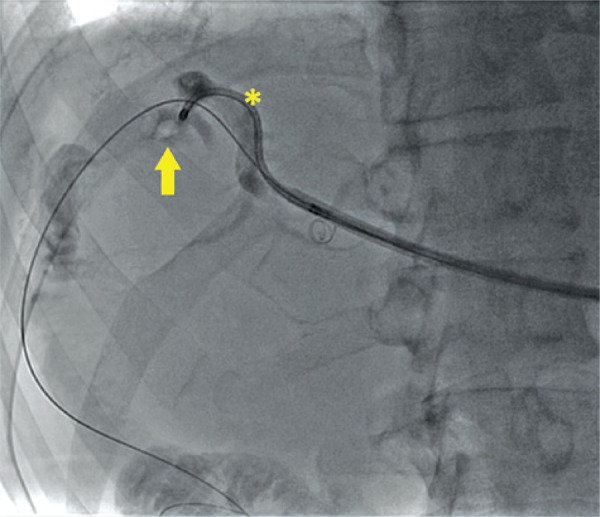
Imagem radioscópica do procedimento com o auxílio do ureteroscópio flexível